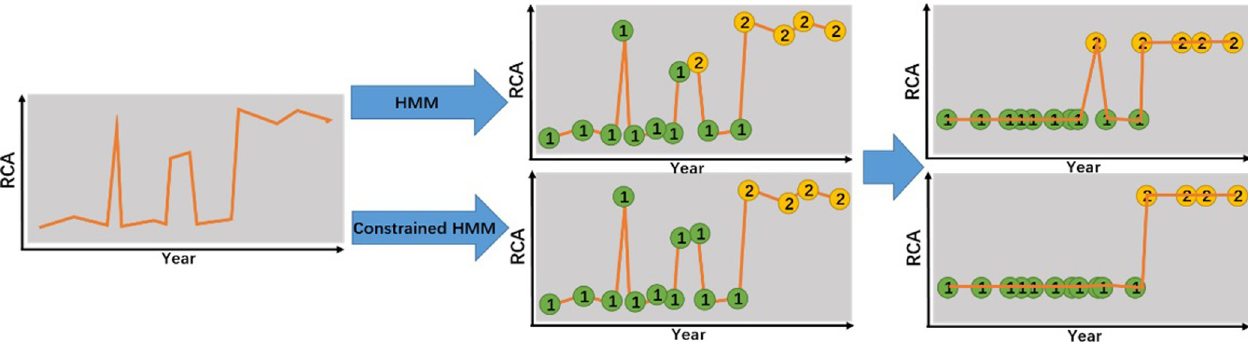
Fig 2. The schematic diagram of the HMM and SDC-HMM. The transition state time series data are obtained from the RCA raw data. Subsequently, the time series data of the development stage are obtained based on the calculation of the emission probability distribution.